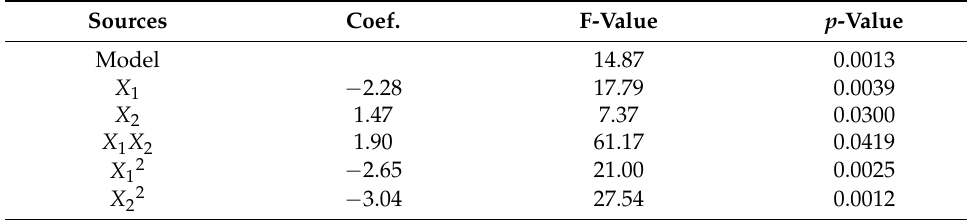
Table 4. Analysis of variance for the quadratic model.